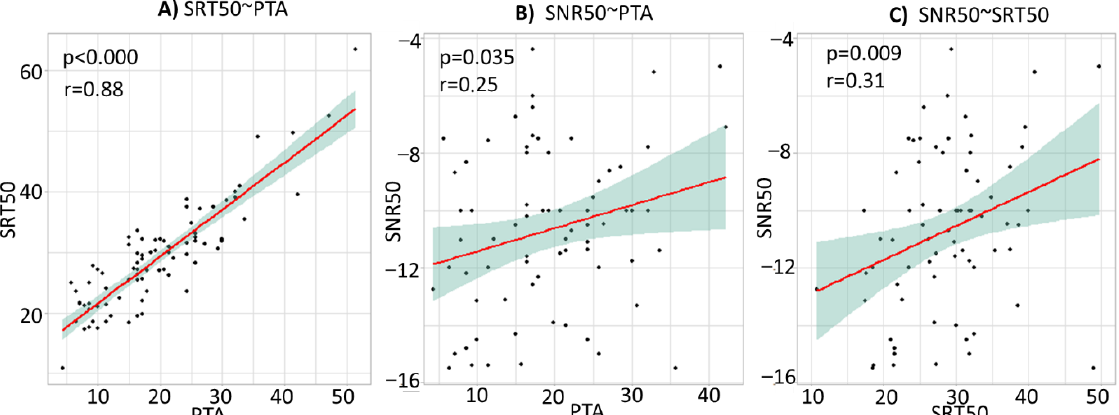
Figure 5. Correlations between the different hearing tests (pure-tone hearing threshold, speech-in-silence and speech-in-noise), for the whole population (Group Y + Group E). ( A ) Correlation and regression line between the pure-tone hearing threshold (PTA) and the speech-in-silence score (SRT50). ( B ) Correlation and regression line between the pure-tone hearing threshold (PTA) and speech-in-noise score (SNR50). ( C ) Correlation and regression line between the speech-in-silence (SRT50) and speech-in-noise (SNR50) scores. The red lines represent the regression lines. The grey areas represent the 95% confidence level interval. The “ r ” represents the Pearson correlation coefficients, and the “ p ” represents the significances of the slopes of the regression lines.